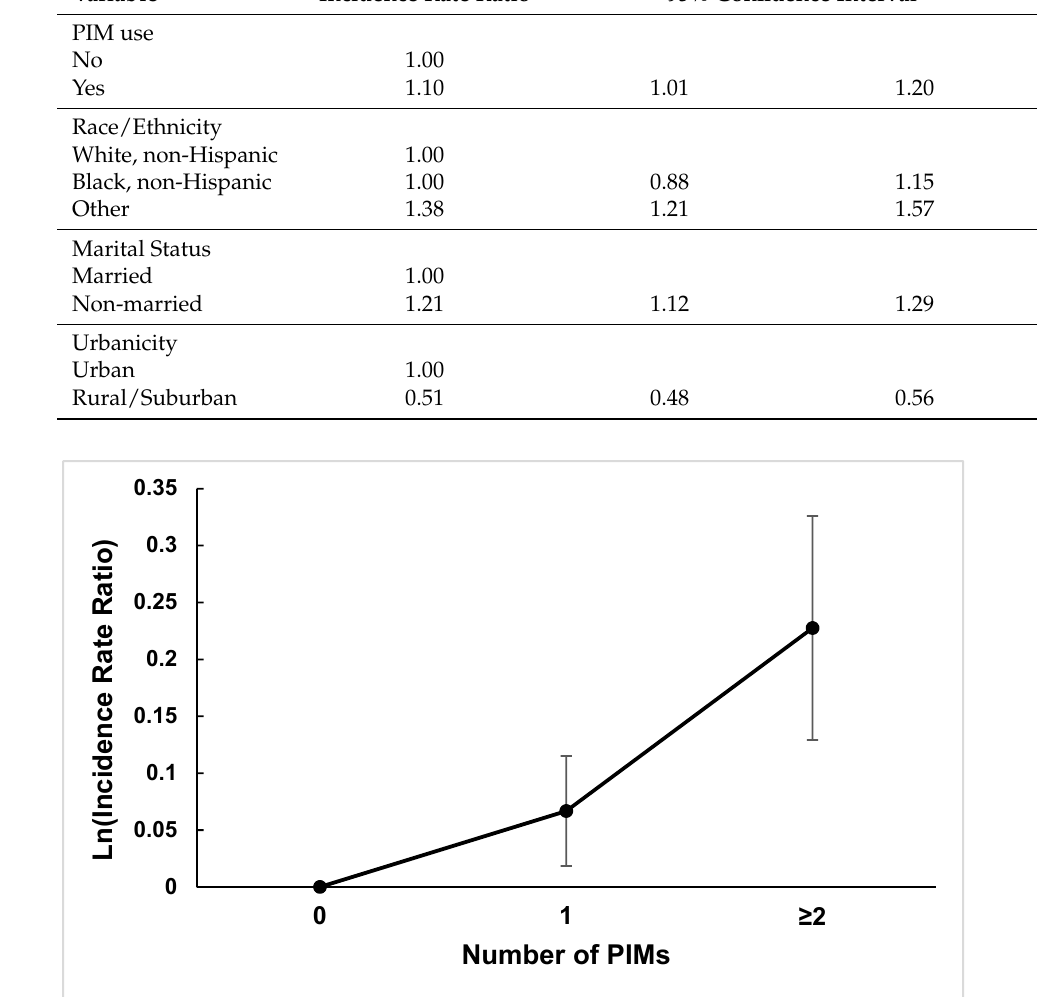
Figure 1. Adjusted incidence rate ratios of hard braking events and 95% confidence intervals according to the number of potentially inappropriate medications (PIMs) used by older drivers, the Longitudinal Research on Aging Drivers (LongROAD) Study .